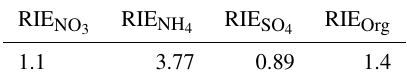
Table 1. Relative ionization efficiencies (RIEs) used for data analy- sis. RIE NH and RIE SO are determined from calibrations with am- 4 4 monium nitrate and sulfate before, during, and after the campaign. RIE NO and RIE Org are literature values (Alfarra et al., 2004; Cana- 3 garatna et al.,